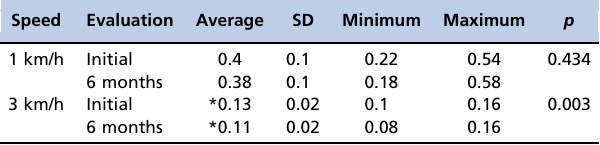
Table 5 - Descriptive statistics for the double-support time (s) at the initial and final (six months after surgery) evaluations at 1 km/h and 3